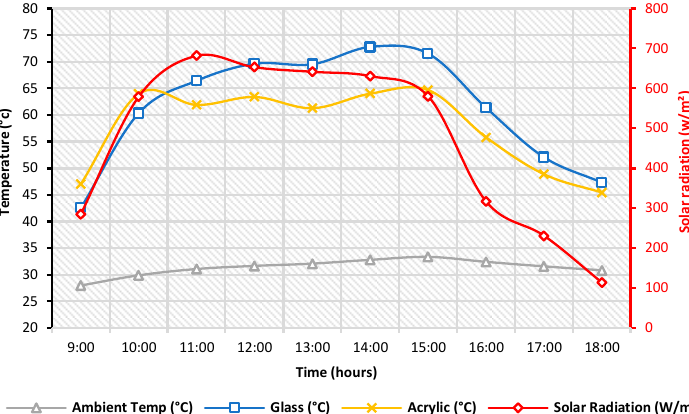
Figure 11. Variation in solar intensity and temperature of desiccant materials on 1 August 2020.